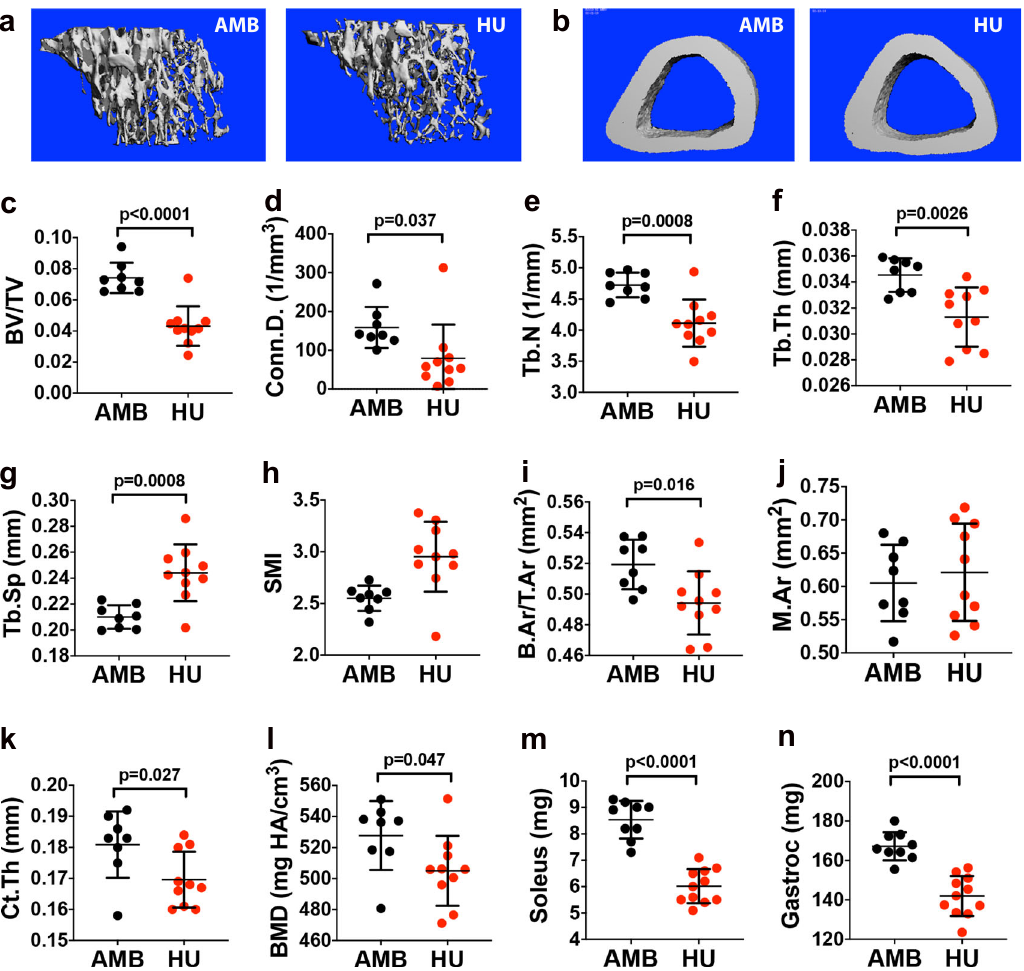
Fig. 1 Mice subjected to 8wk of HU exhibit localized skeletal pathology and muscle atrophy. a , b Representative micro-CT images of the proximal ( a ) and distal tibia ( b ) from 8wk HU mice and their respective AMB controls. c – h Quanti fi cation of BV/TV ( c ), Conn.D. ( d ), Tb.N. ( e ), Tb. Th. ( f ), Tb.Sp. ( g ), and SMI ( h ) by micro-CT analysis ( n = 8 – 10 mice/group). i – l Quanti fi cation of B.Ar/T.Ar ( i ), M.Ar. ( j ), Ct.Th. ( k ), and BMD ( l ) by micro-CT analysis ( n = 8 – 10 mice/group). m , n Quanti fi cation of soleus ( m ) and gastrocnemius ( n ) wet mass ( n = 9 – 14 mice/group). Data represent mean ± SD. All p -values are by Student ’ s t -test (AMB vs. HU